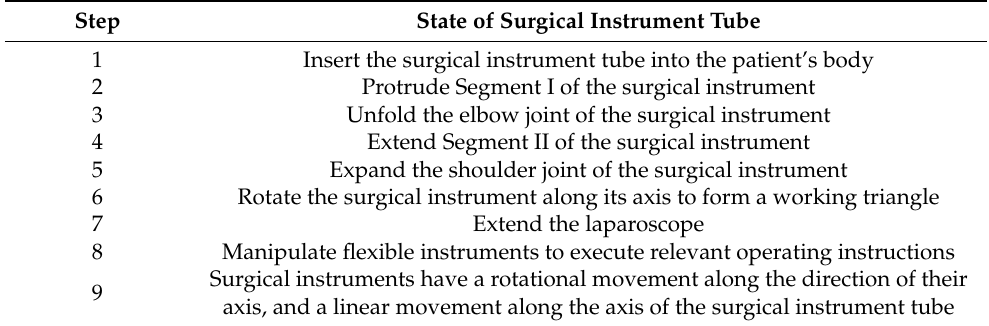
Table 2. Workflow of the surgical instrument